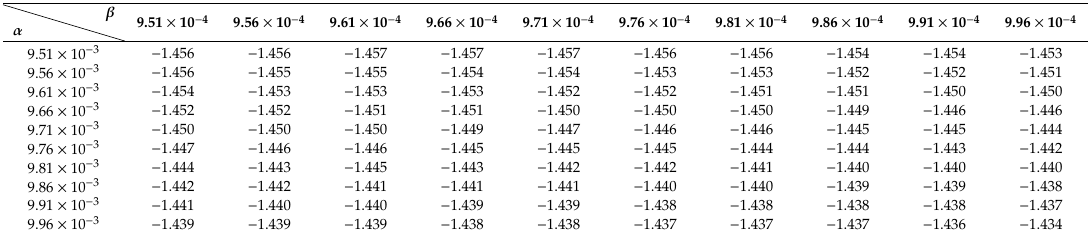
Table 6. Beaked Whale with di ff erent α , β corresponding to SNR data.